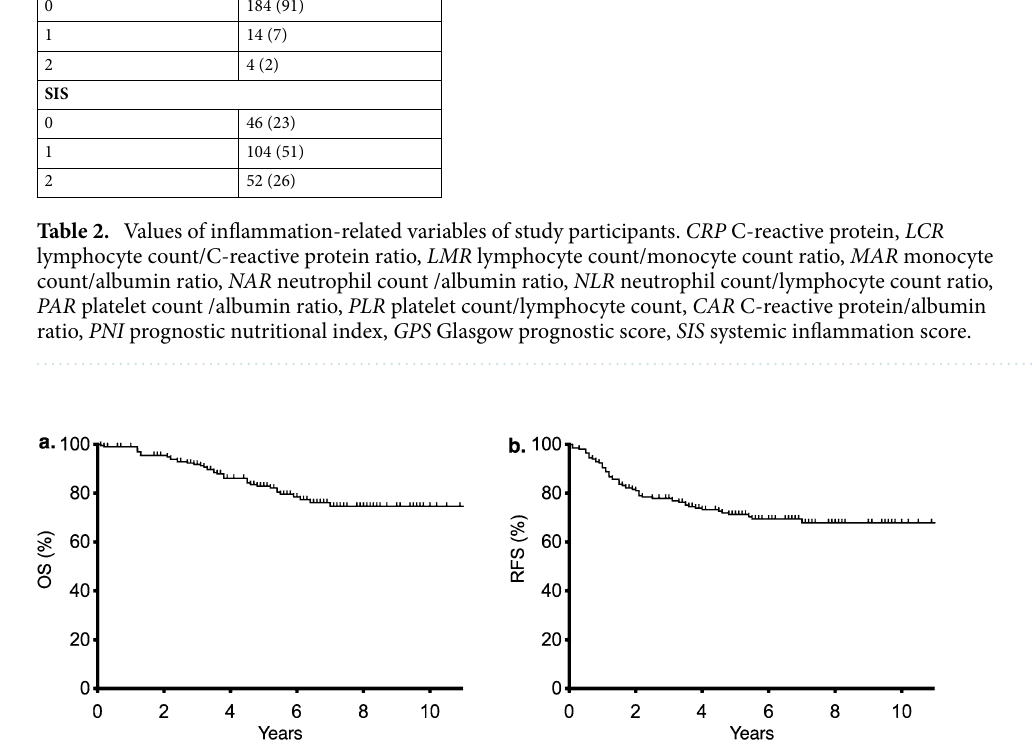
Figure 1. ( a ) Overall survival (OS) and ( b ) recurrence-free survival (RFS) of all study